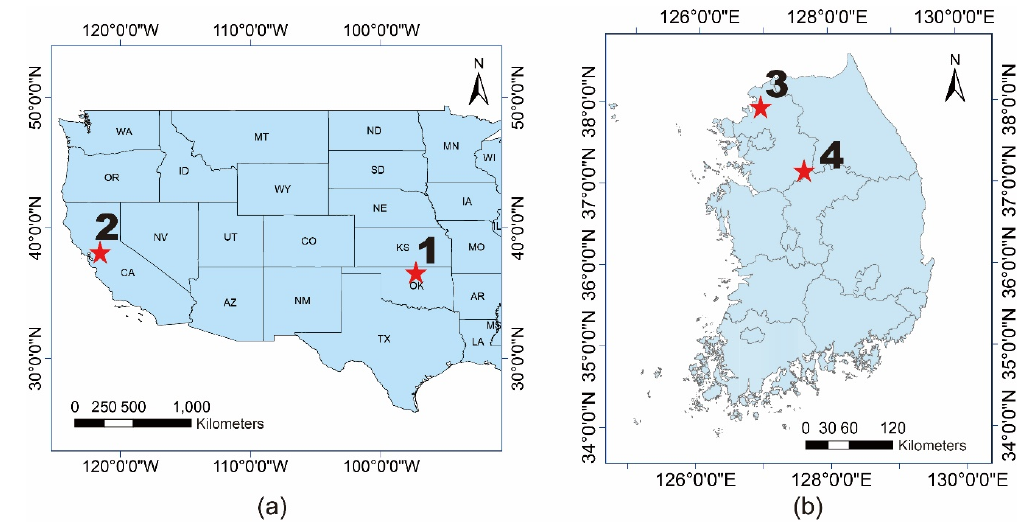
Figure 1. Location of the study Sites 1, 2, 3 and 4 over ( a ) US and ( b ) South Korea.